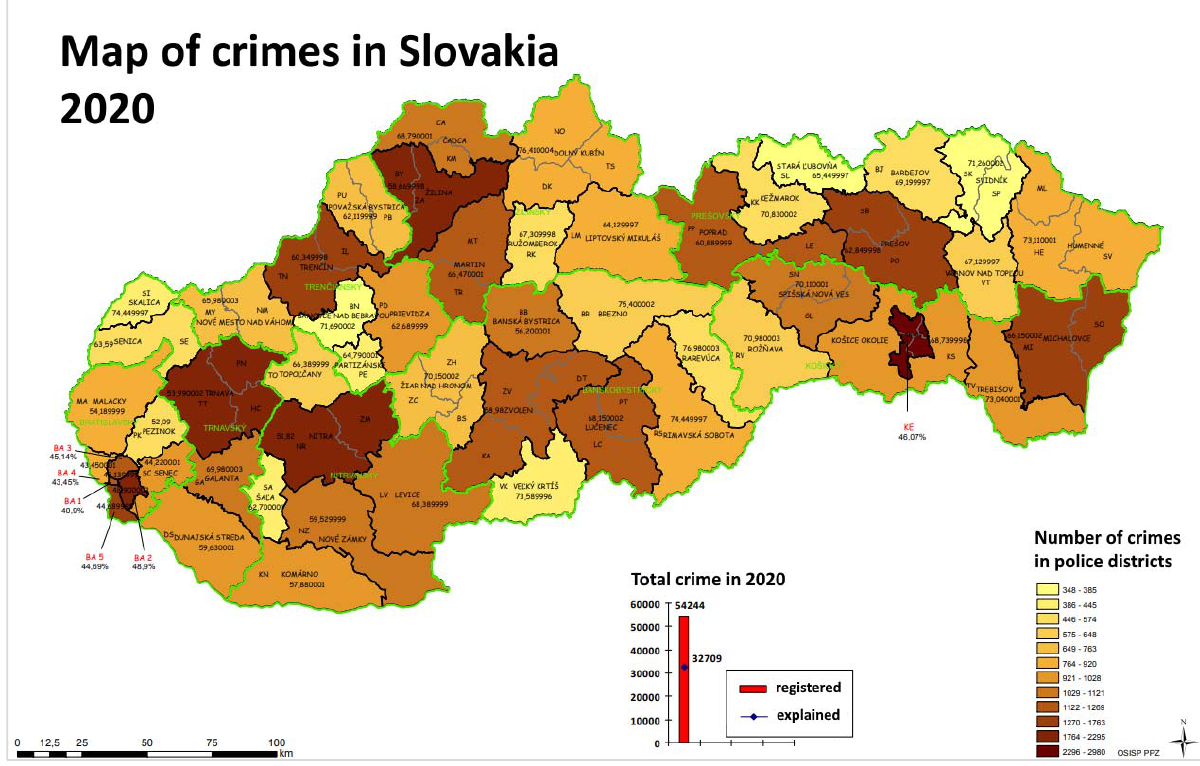
Figure 1. Map of crimes in Slovakia, the year 2020